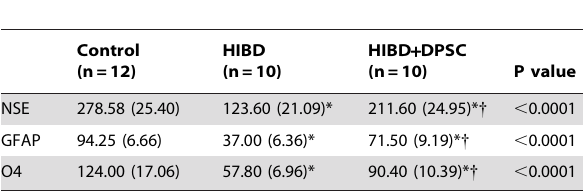
Table 3. Immunohistochemical Results for NSE, GFAP, and O4 in Rat Cerebral